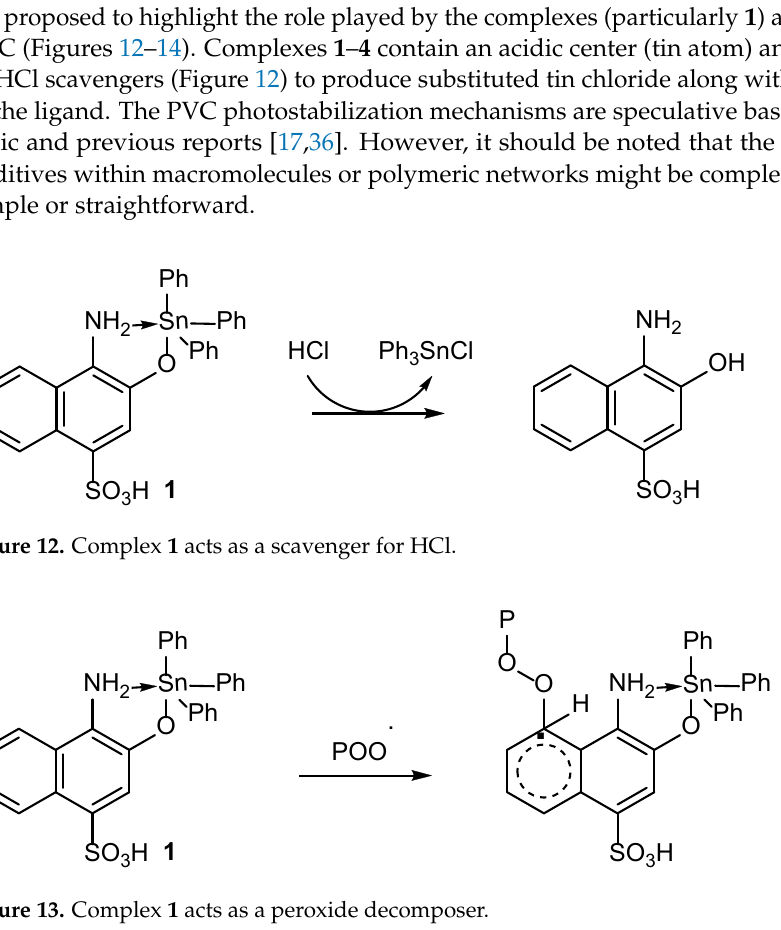
Figure 13. Complex 1 acts as a peroxide decomposer.